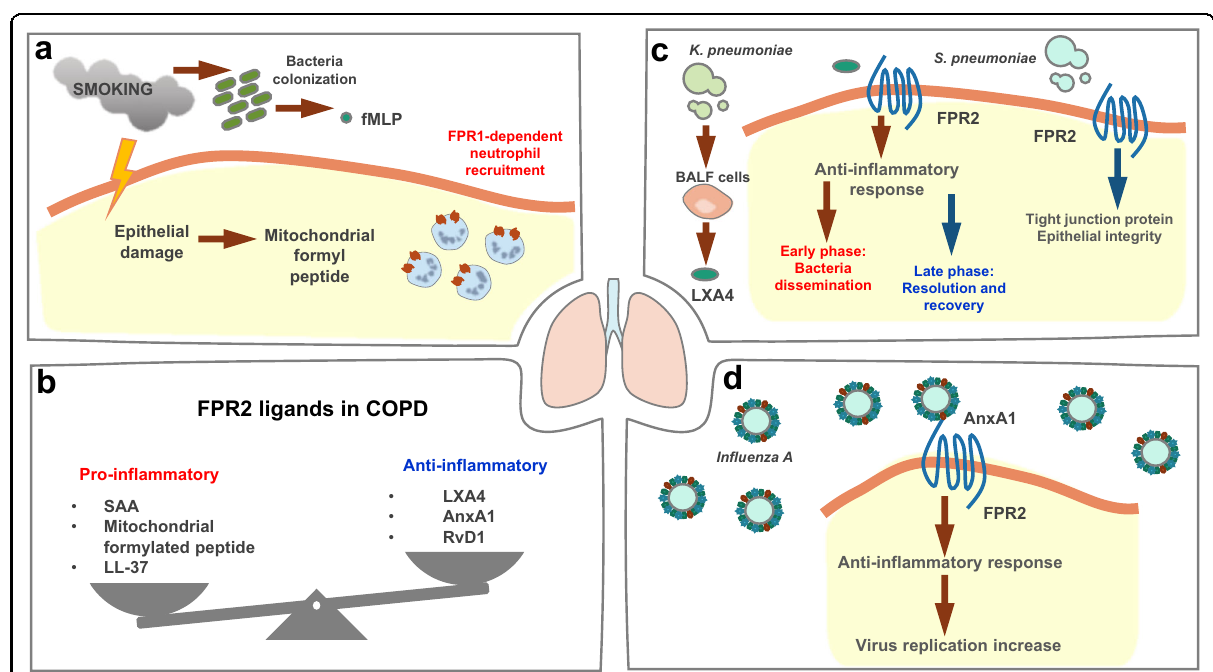
Fig. 2 Functional roles of FPRs in the regulation of respiratory diseases. a Smoking induces lung damage and structural changes, eliciting augmented bacterial colonization in the lower respiratory tract, with increased production of fMLP. b In COPD, in fl ammatory FPR2 ligands are produced at higher levels than anti-in fl ammatory FPR ligands. c Klebsiella pneumoniae infection stimulates BALF cells to produce LXA4, which induces an anti-in fl ammatory response leading to bacterial dissemination in the early phase of infection and is required for resolution and recovery in the late phase of infection. However, FPR2 is required for maintaining epithelial integrity against Streptococcus pneumoniae infection. d AnxA1 is incorporated into in fl uenza A virus particles, stimulating FPR2-mediated signaling to block defense activity against virus